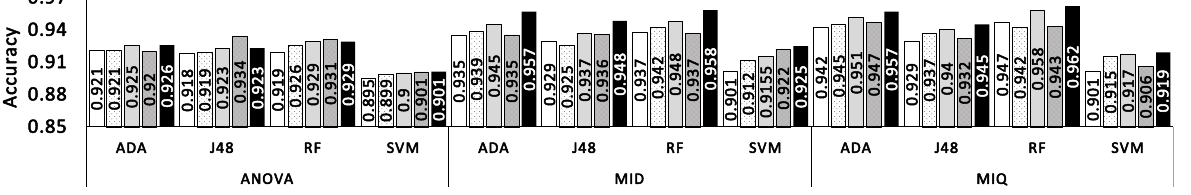
Figure 6. Performance of 4-gram features.